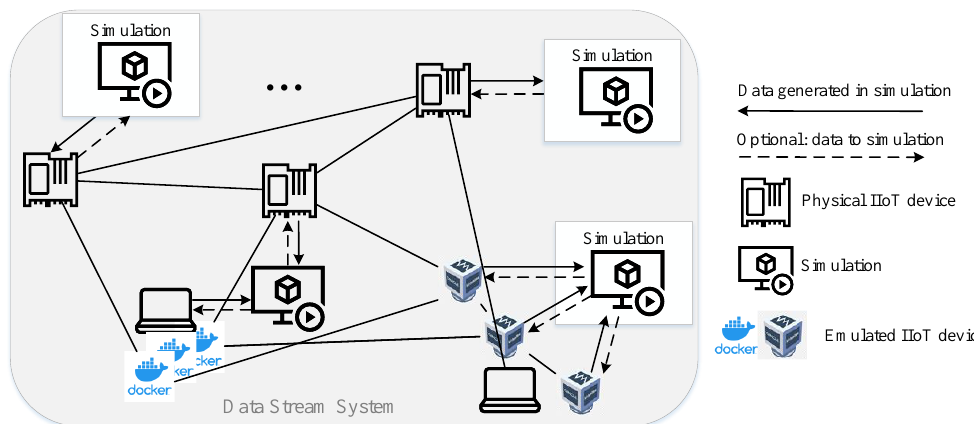
Figure 7. Architecture 3: several networked devices and distributed